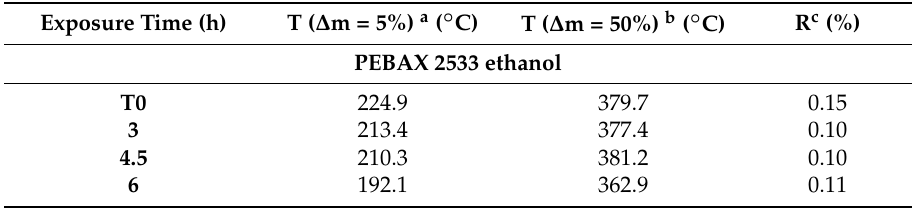
Table 4. Thermogravimetric analysis (TGA) properties of Pebax ® 2533 films at T0 and after 3, 4.5, and 6 h of photo-oxidative